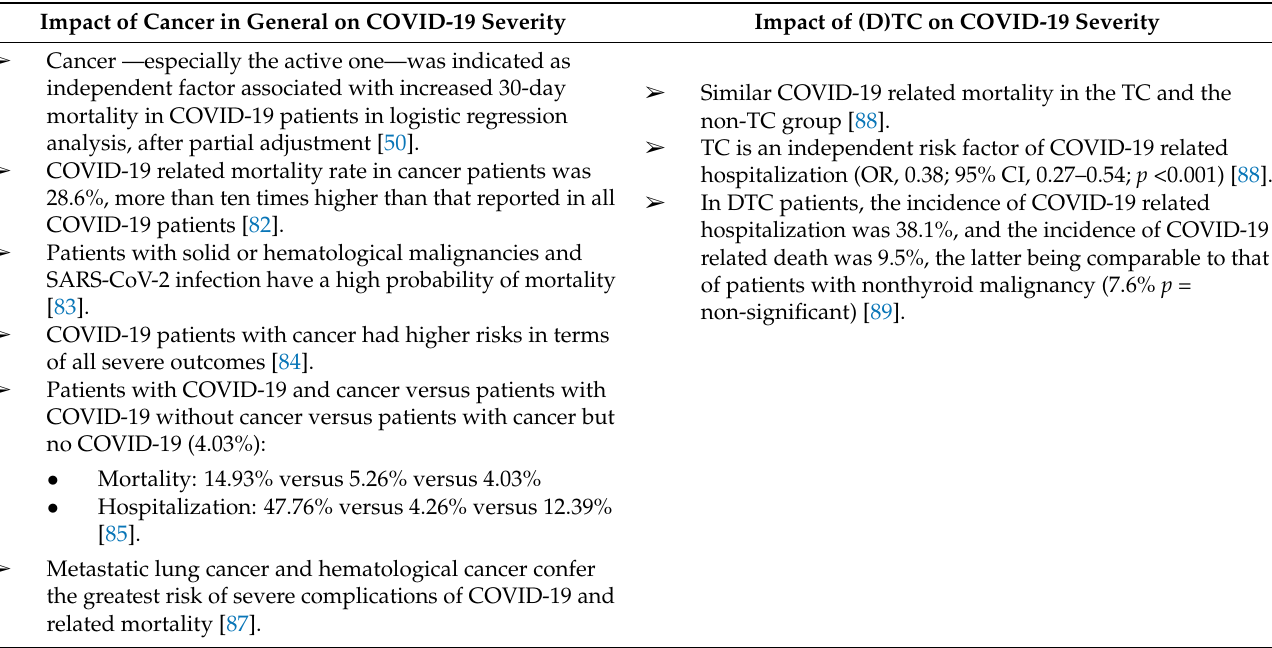
Table 5. Varying, occasionally discordant, data on the impact of cancer on COVID-19 severity between cancer patients in general and (D)TC patients. Impact of Cancer in General on COVID-19 Severity Impact of (D)TC on COVID-19